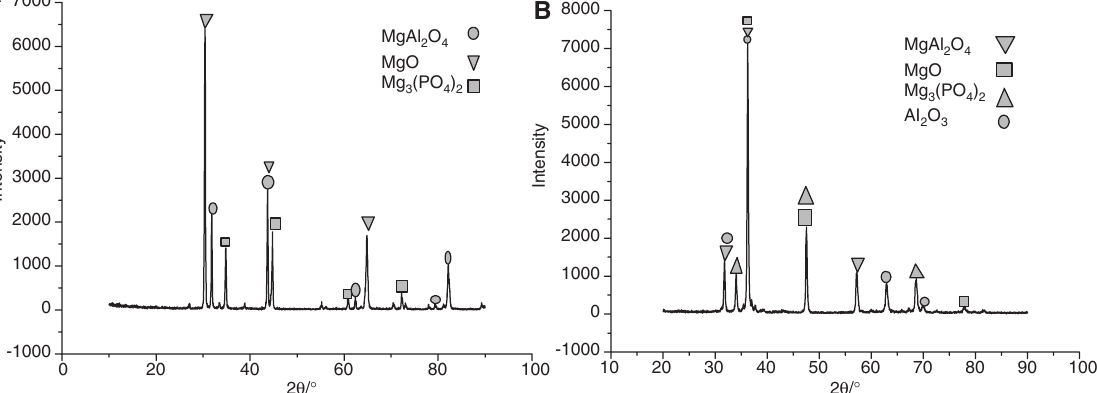
O (B) Ceramic membrane after added 2 3.